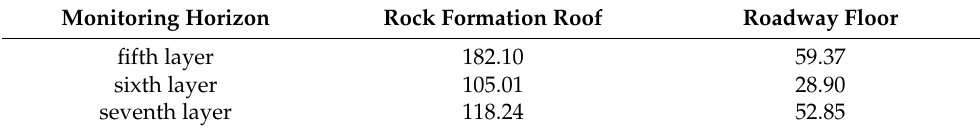
Table 3. Peak acceleration increasing trend.